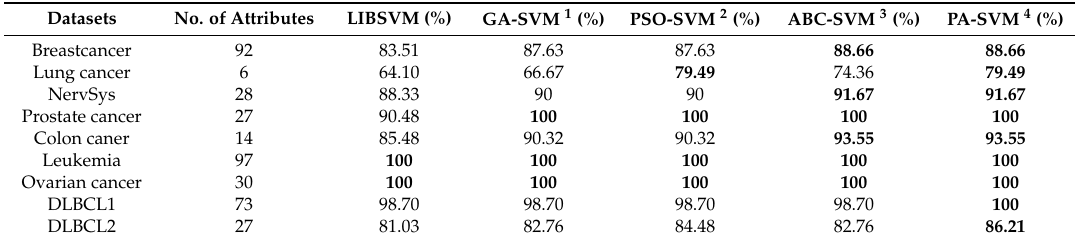
Table 2. Classification accuracy of different